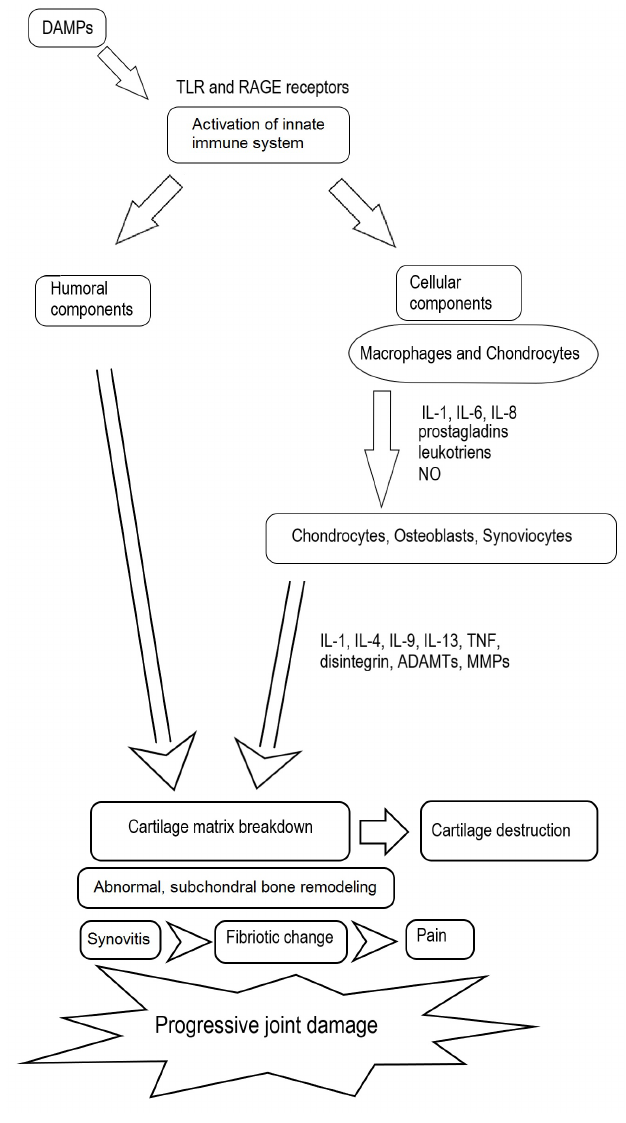
Figure 1. Joint damage mechanisms.